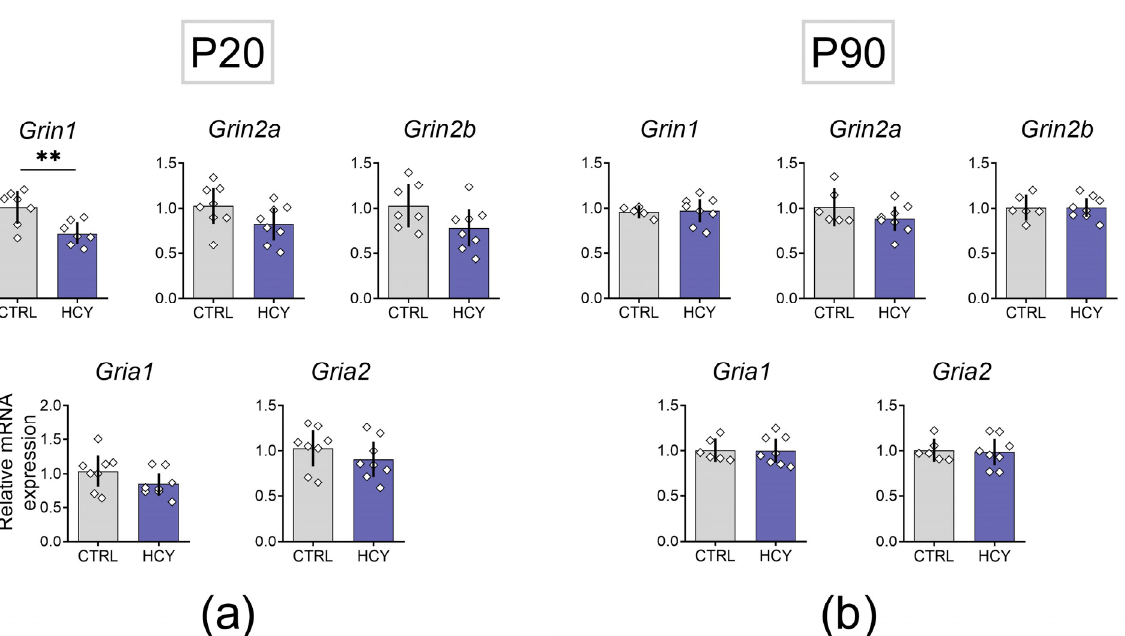
Figure 7. Western blot of GluN1 subunit of NMDAR in control (1,3,5,7) and HCY (2,4,6,8) rats on P20. On ( a ) the representative bands of the GluN1 and actin protein. ( b ) presents the results of